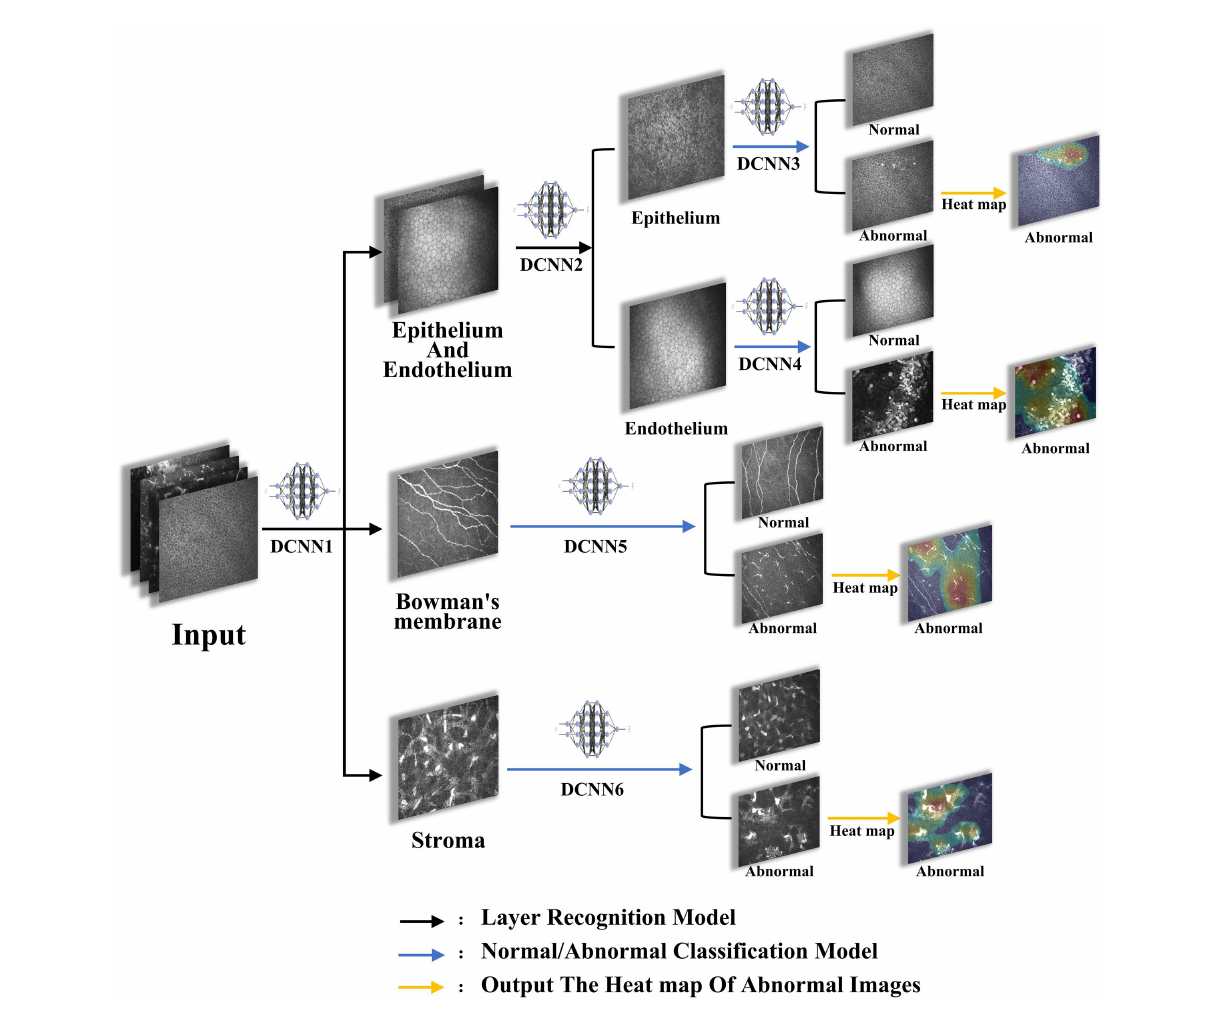
FIGURE 1 The flowchart of the model. Images were imported into the proposed architectures, initially sorted by DCNN1 to recognize epithelium/endothelium, bowman’s membrane, and stroma, and were then sorted by DCNN2 to recognize epithelium and endothelium. Afterwards, images of each layer were classified to abnormal and normal by DCNN3, DCCN4, DCCN5, and DCCN6. Finally, the heat map of abnormal images was